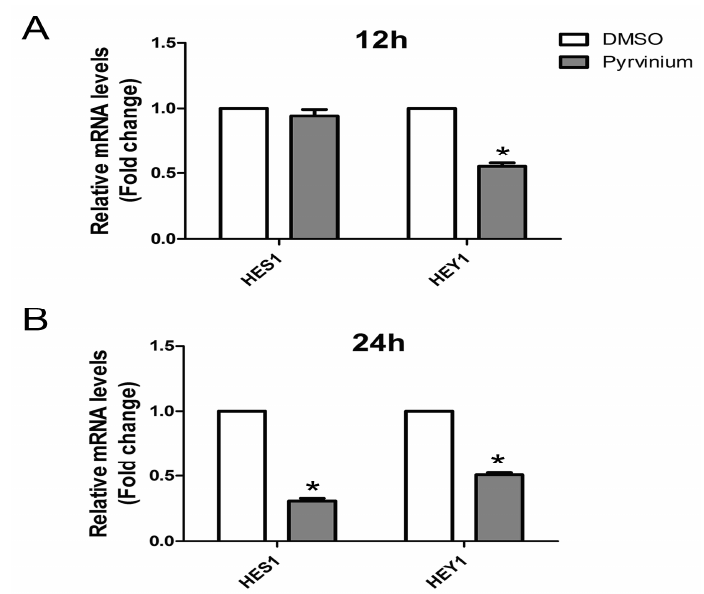
Figure 5. Pyrvinium suppresses the Notch signaling pathway during adipogenic di ff erentiation. C3H10T1 / 2 cells were treated with DMSO or pyrvinium under adipogenic di ff erentiation medium. Expressions of the Notch target genes Hes1 and Hey1 were measured by real-time PCR for 12 h ( A ) or 24 h ( B ). The data are presented as mean ± SEM from three independent experiments. Statistical significance was determined compared with control group ( ∗ p < 0.05).